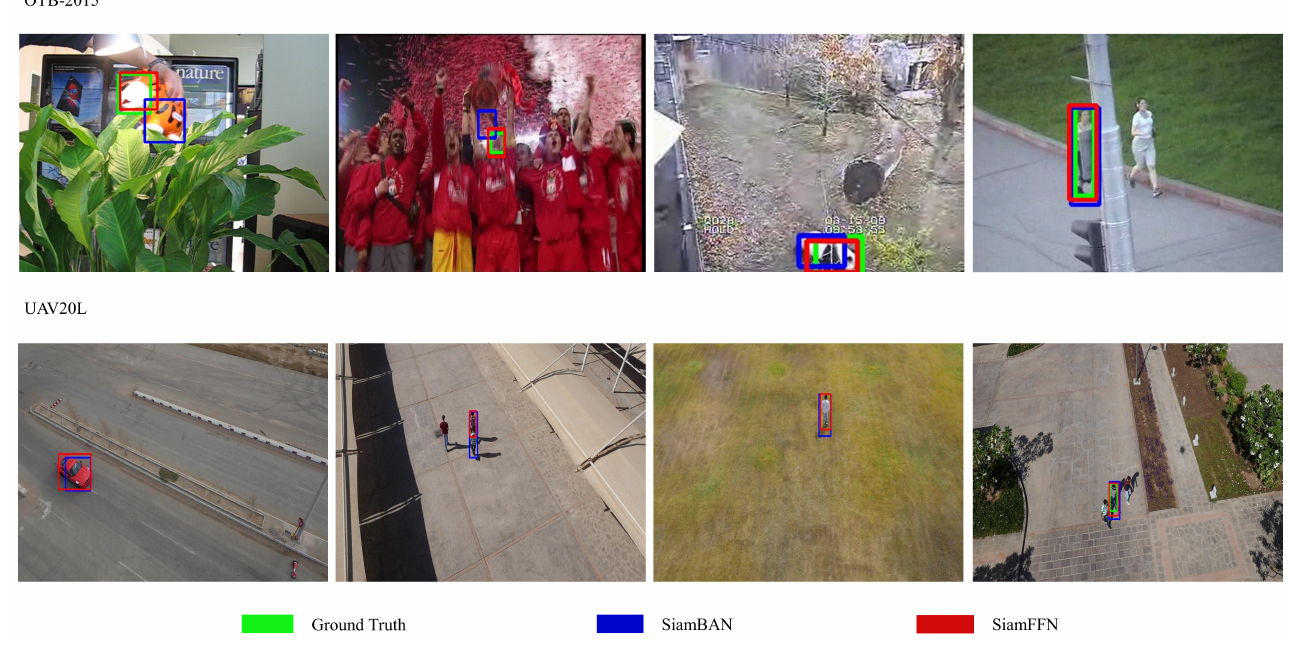
Figure 7. Visualization of tracking results on videos from different datasets. Table 2. Analysis of Computational